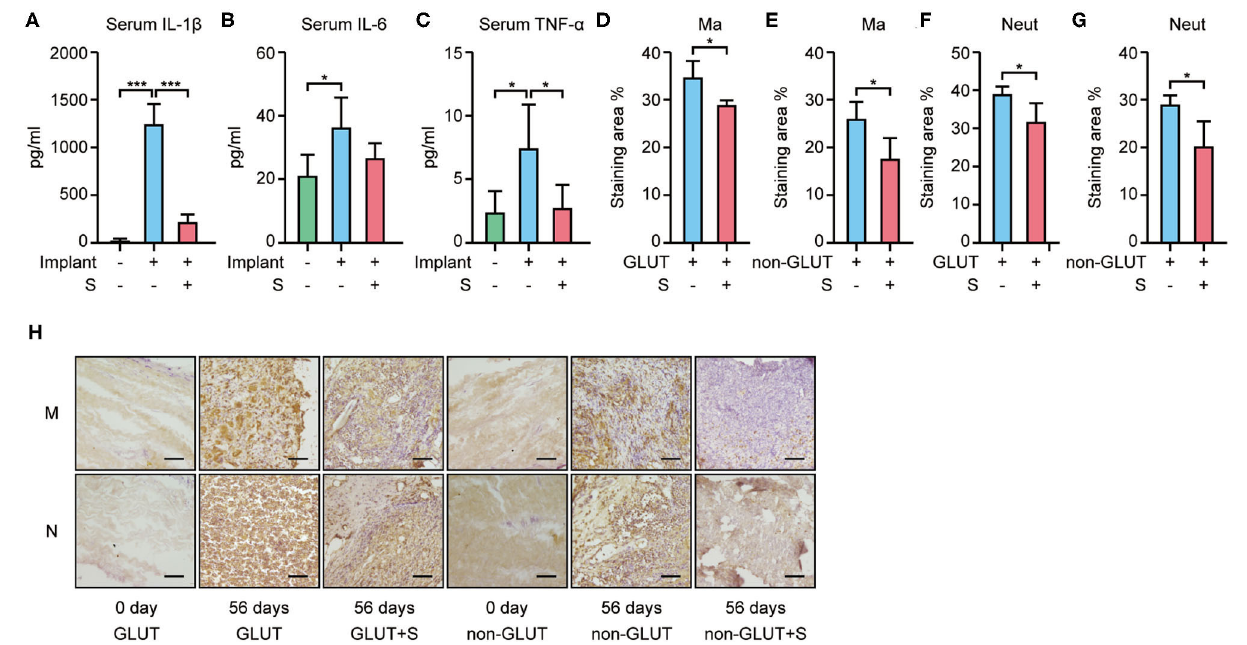
Frontiers in Cardiovascular Medicine |